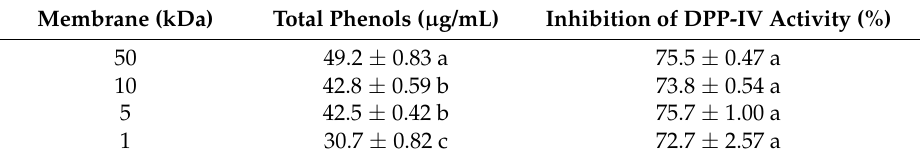
Table 1. The inhibitory ratio on dipeptidyl peptidase IV (DPP-IV) by ultrafiltrate of Lapsang souchon from different membranes ( n = 3). General linear model (GLM) followed by Ryan–Einot–Gabriel–Welsch’s (REGWQ’s) multiple range test. Means with different letters (a, b, c) have significant difference ( p < 0.05).